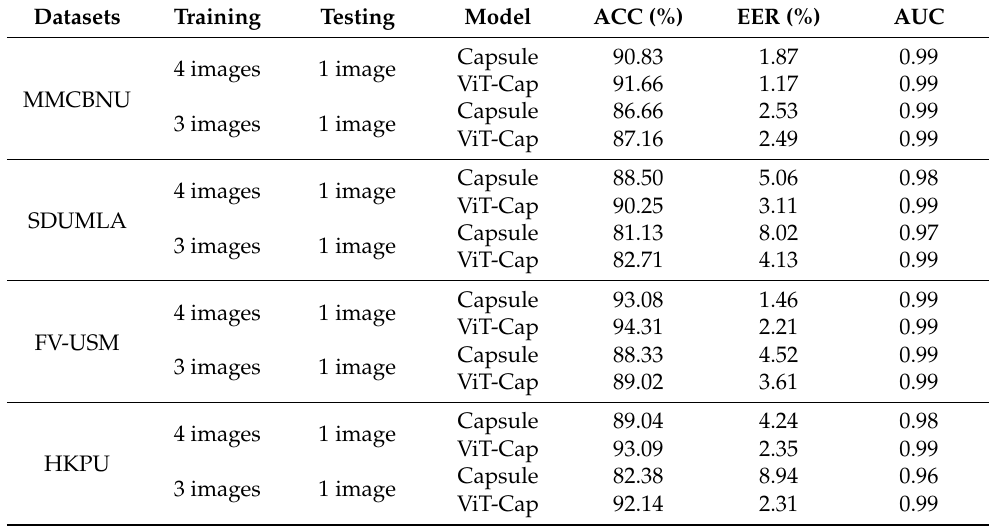
Table 7. Finger vein recognition performance of ViT-Cap on small sample datasets.